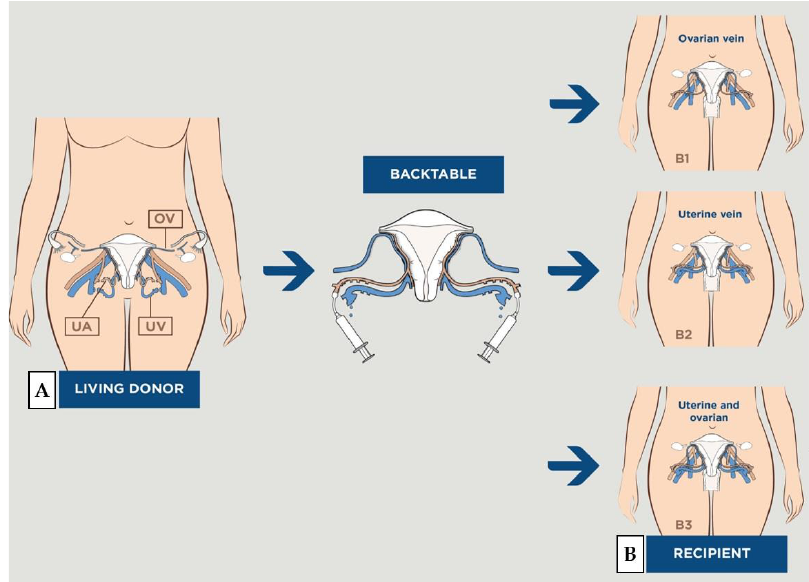
Figure 1. Schematic drawing of vascularization during uterus transplantation. EIA = external iliac artery; EIV = external iliac vein; I IA = internal iliac artery; OV = ovarian vein; UA = uterine artery; UV = uterine vein. ( A ) Vascularization obtained during uterine harvesting in the donor. ( B ) The uterus in place in the pelvis of the recipient with bilateral end-to-side anastomoses on the recipient ’ s external iliac vessels: ( B1 ) with ovarian vein, ( B2 ) with uterine vein, ( B3 ) with both. Based on experimentation that was carried out with various animal models, ewes with humans in terms of body size, pelvic anatomy, and uterine vessel size [17,18]. Thus,